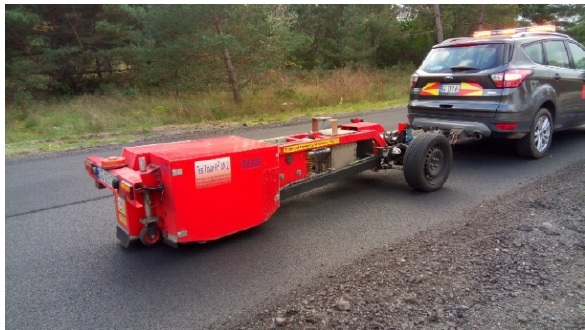
Figure 4. Test trailer R 2 Mk.2 for tire rolling resistance measurements.